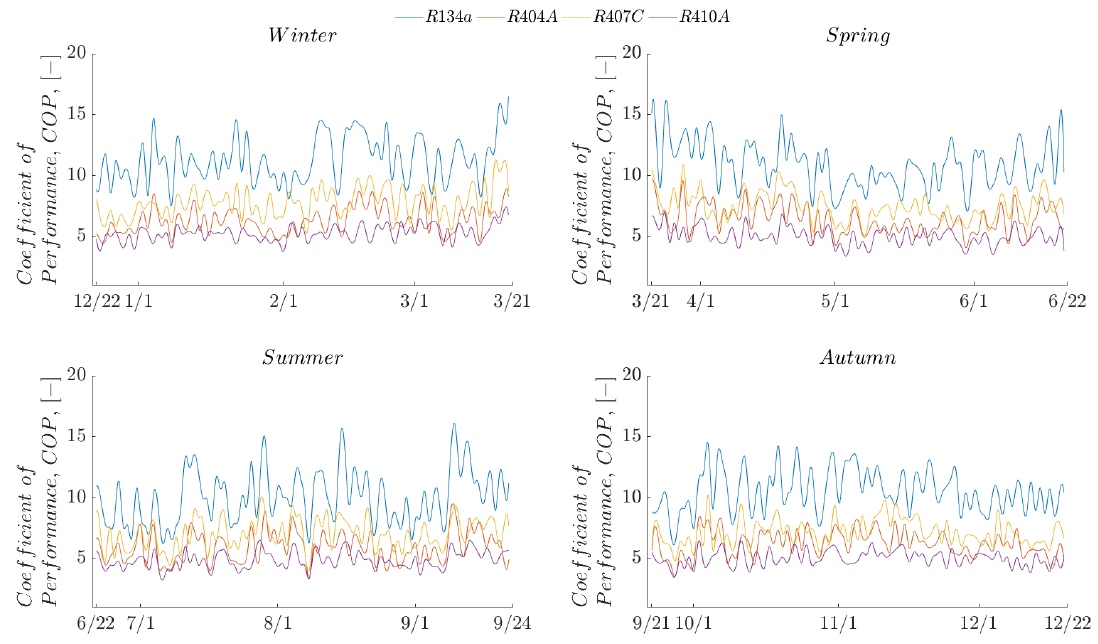
Figure 26. Seasonal coefficient of performance of the optimized system for all refrigerants.